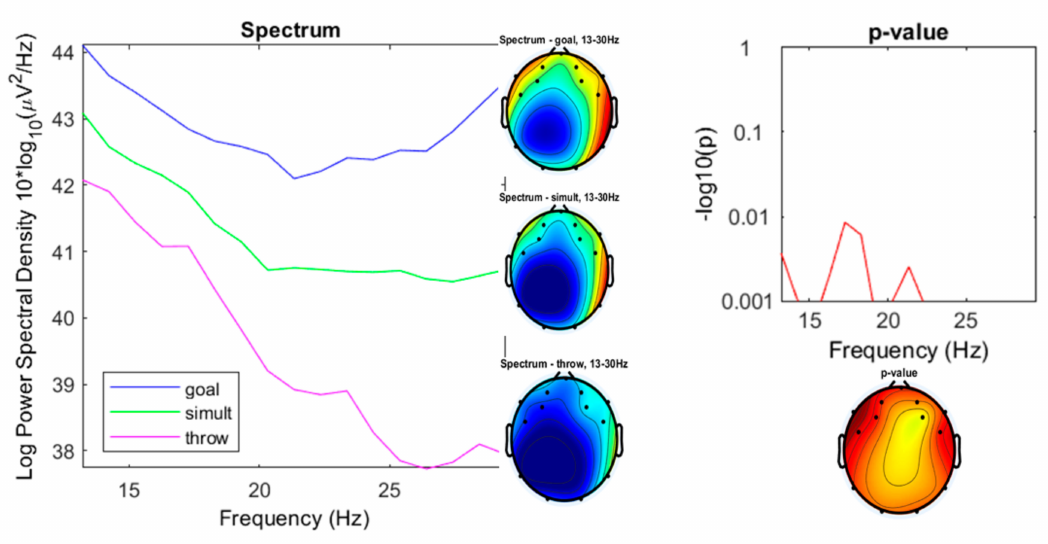
Figure 11. Spectrum plotting of the three conditions components (“throwing,” “goal,” “simultaneous”), with their plot averaged topography over frequency range, and the p -value plot for frequencies from 7 to 13 Hz (beta).